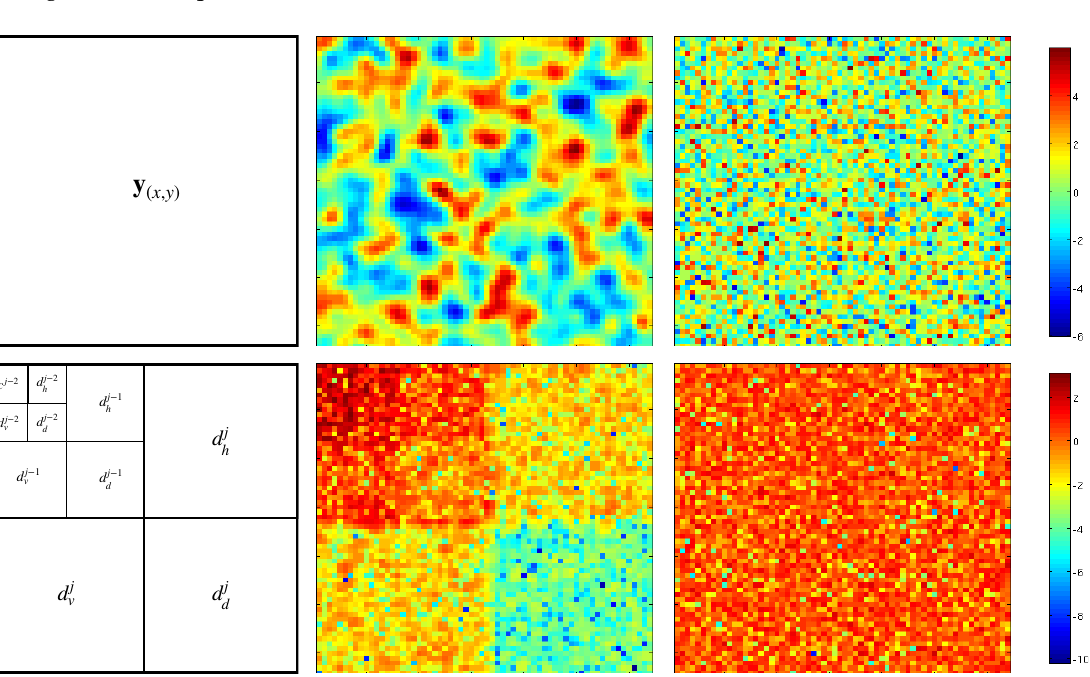
à 4 moments nuls pour les deux bruits présentés en figure 5.6. Afin de mieux distinguer la variance des coefficients à petite échelle, le logarithme de la variance est présenté.